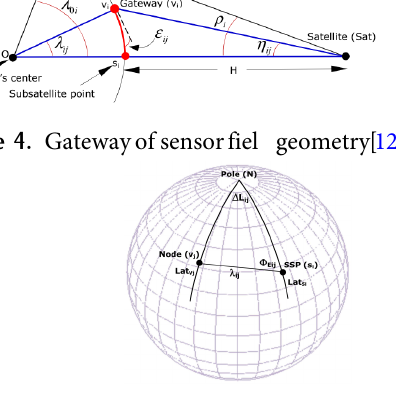
Figure 5. Relationshipbetween sensor node of a DSF and sub- satellite point[12].